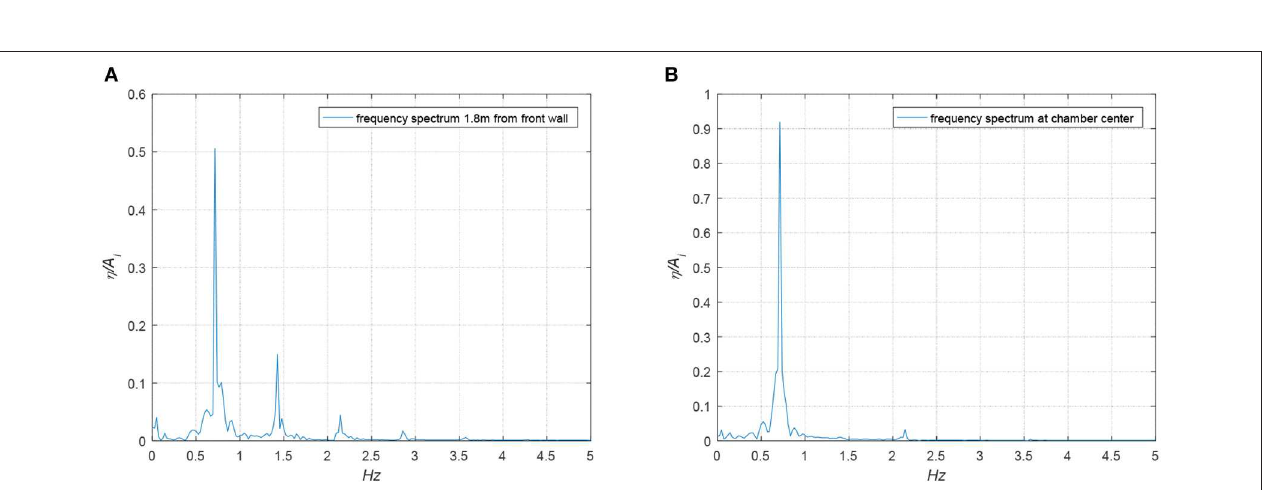
Frontiers in Energy Research |